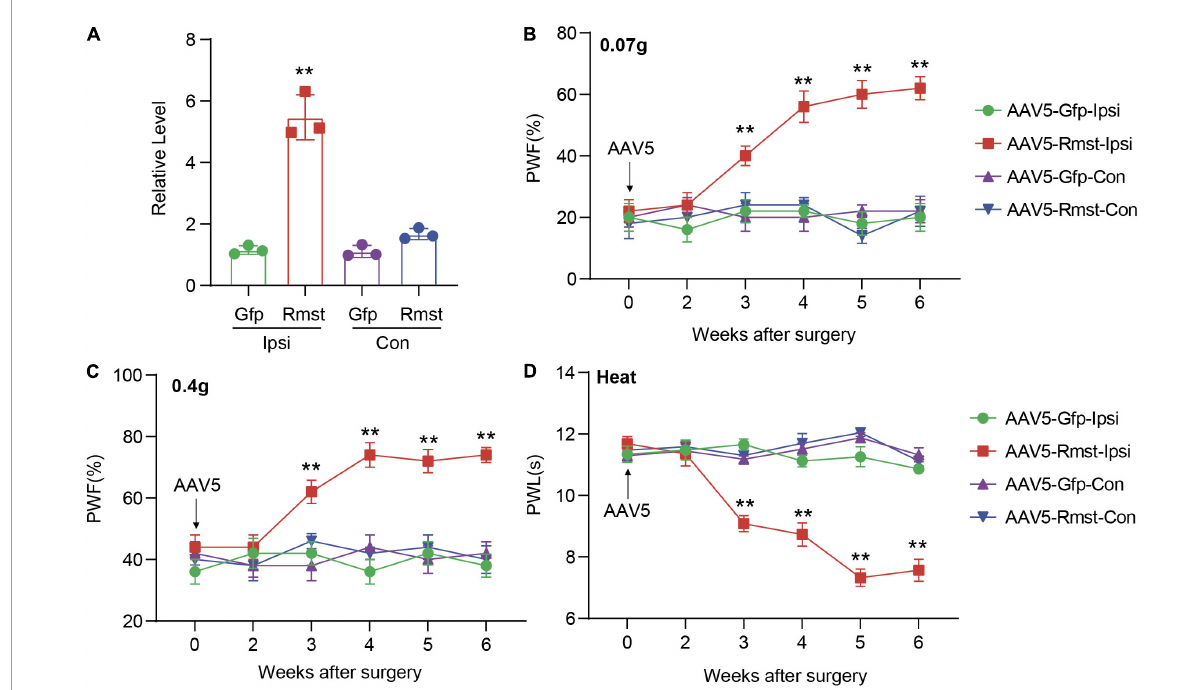
FIGURE4 Overexpression of DRG rhabdomyosarcoma 2-associated transcript ( Rmst ) produced nociceptive hypersensitivity in naïve mice. (A) Rmst expression in L3/4 DRGs 6 weeks after receiving AAV5-Rmst or AAV5-Gfp. n = 6 mice, two-tailed unpaired Student’s t- test, ** P < 0.01 compared with AAV5-Gfp group. (B–D) The PWF to von Frey filament (B,C) and the PWL to thermal stimuli (D) on mice with DRG microinjection of AAV5-Rmst or AAV5-Gfp. n = 6, two-way ANOVA followed by post-hoc Tukey test, ** P < 0.01 compared with AAV5-Gfp-Ipsi